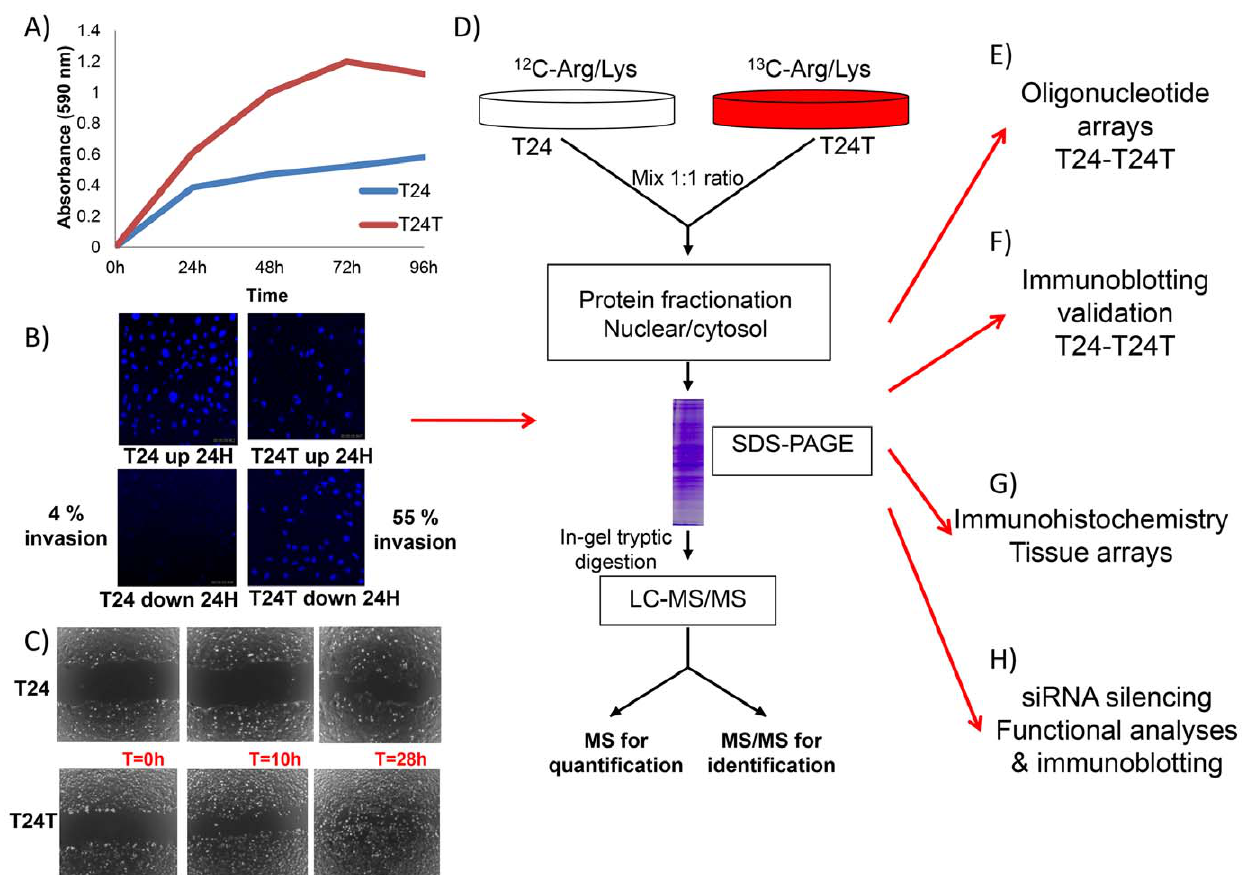
Figure 1. Cell line phenotypes and experimental design. Functional analyses were performed to assess the differential aggressive phenotype of T24 and T24T bladder cancer cells on: A ) proliferation, B ) invasion, and C ) migration. The average of duplicate experiments for each functional assay of these cells at several timepoints is represented in each panel. D ) Schematic diagram showing the workflow used for the multiplexed SILAC- based experiments. Internal labelling was performed in vitro , the protein extracts were fractionated via SDS-PAGE, digested with trypsin in gel, and tryptic digests were analyzed by LC-MS/MS to both identify and quantify the proteins present. E) Comparison of the protein changes identified by SILAC was performed with those observed by oligonucleotide arrays. F ) Validation of the protein changes identified by SILAC in Western blots of protein extracts obtained from T24-T24T cells. G ) Immunohistochemistry on tissue arrays containing bladder tumors served to validate associations of identified proteins with clinicopathological variables in bladder cancer. H ) siRNA silencing of identified proteins and subsequent functional analyses and immunoblotting validation served to evaluate the impact of identified candidates on the aggressive phenotype of T24T and the regulation of other differentially expressed proteins identified by